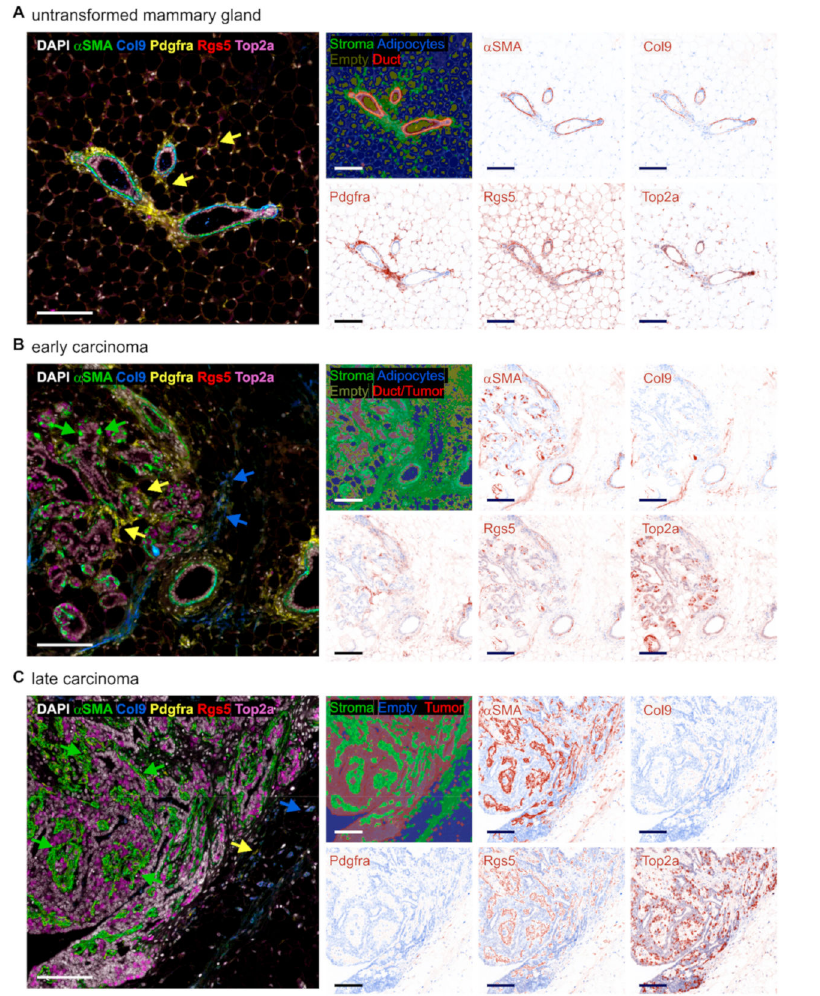
Figure 1. Histology of cancer-associated fibroblast (CAF) subset marker expression during PyMT tumor development. Untransformed mammary glands ( A ) as well as early (8–12 weeks) ( B ) and late-stage (18–20 weeks) ( C ) PyMT tumors were harvested and CAF subset marker expression was analyzed by PhenOptics. Representative images show expression of the activated fibroblast marker α SMA, the developmental CAF (dCAF) marker Col9, the matrix CAF (mCAF) marker Pdgfra, the vascular CAF (vCAF) marker Rgs5, and the cycling CAF (cCAF) marker Top2a. Nuclei were counterstained with DAPI. Large images display coexpression of all markers, with colored arrowheads indicating fibroblasts expressing the marker shown in the same color. The smaller images show tissue segmentation and single stainings computed using InForm software. Scale bars: 100 µ